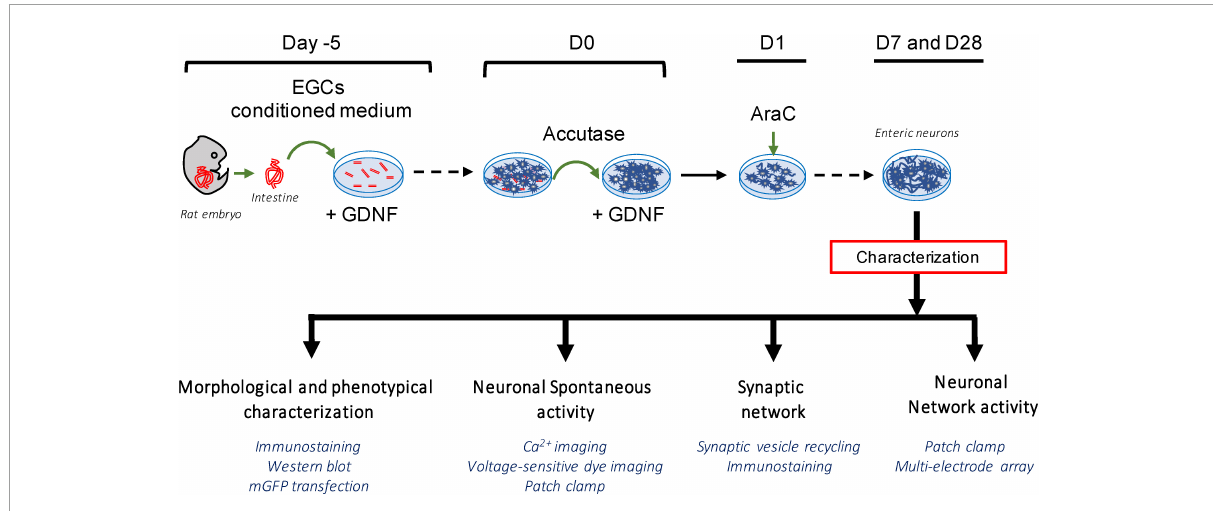
FIGURE1 Schematic summary of the experimental protocol for the establishment of a highly pure culture of enteric neurons.